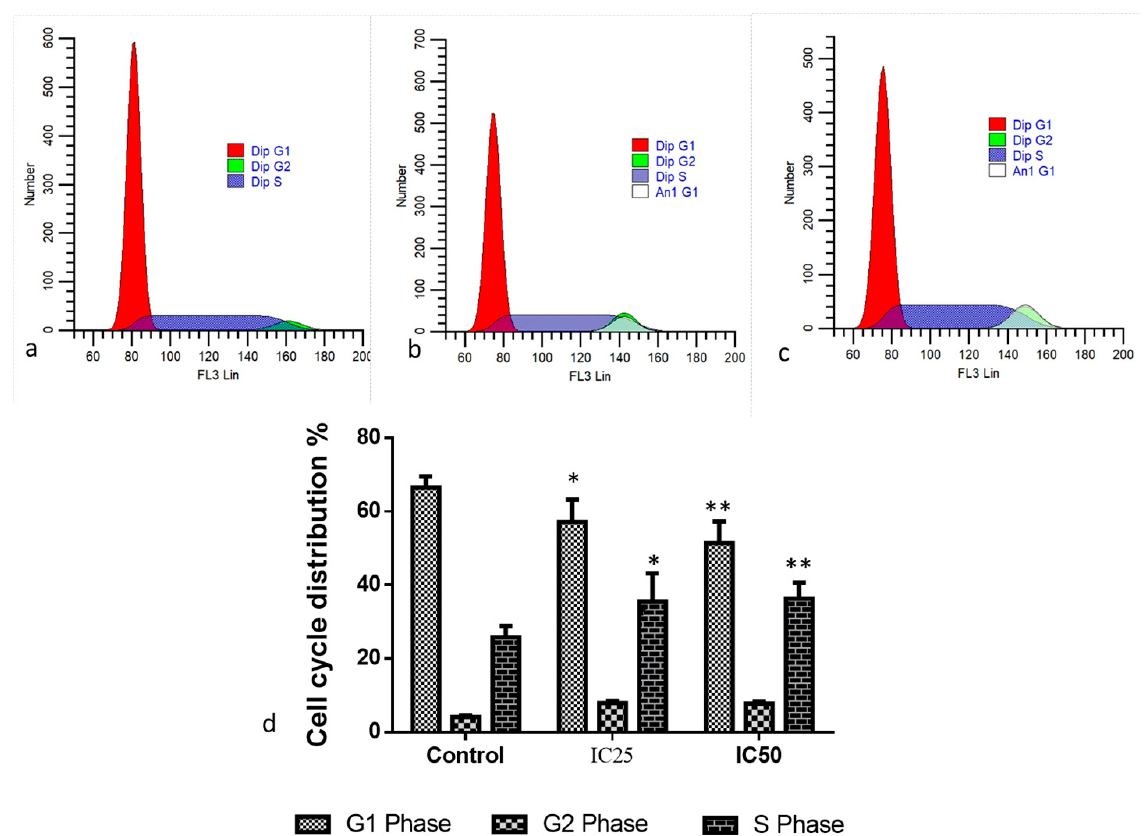
Figure 5. Cell cycle analysis was performed using flow cytometry after staining with Propidium Iodide (PI). Albumin and visnagin NPs were administered to MDA-MB-468 cells at IC50 concentra- tions for 48 h compared with controls. An analysis of cell cycle patterns and apoptosis distribution in untreated or control ( a ) and albumin and visnagin NP-treated cells, and their concentrations of IC25 ( b ) and IC50 ( c ). Percentage of cell cycle distribution ( d ). (* signifies p < 0.05 when compared with control, ** signifies p < 0.001 when compared with control).